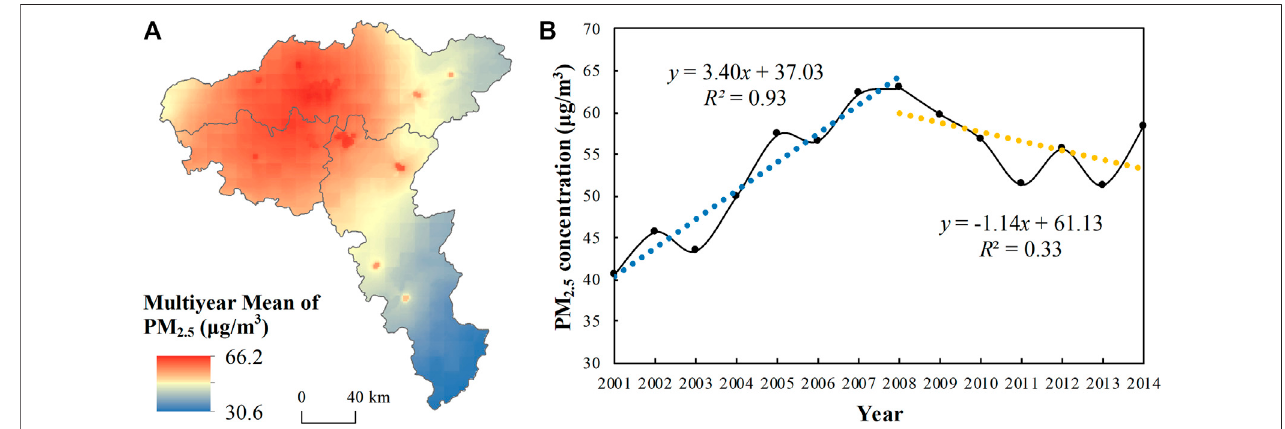
FIGURE 5 | (A) Multiyear mean of the PM 2.5 concentration and (B) the annually averaged PM 2.5 concentration variations from 2001 to